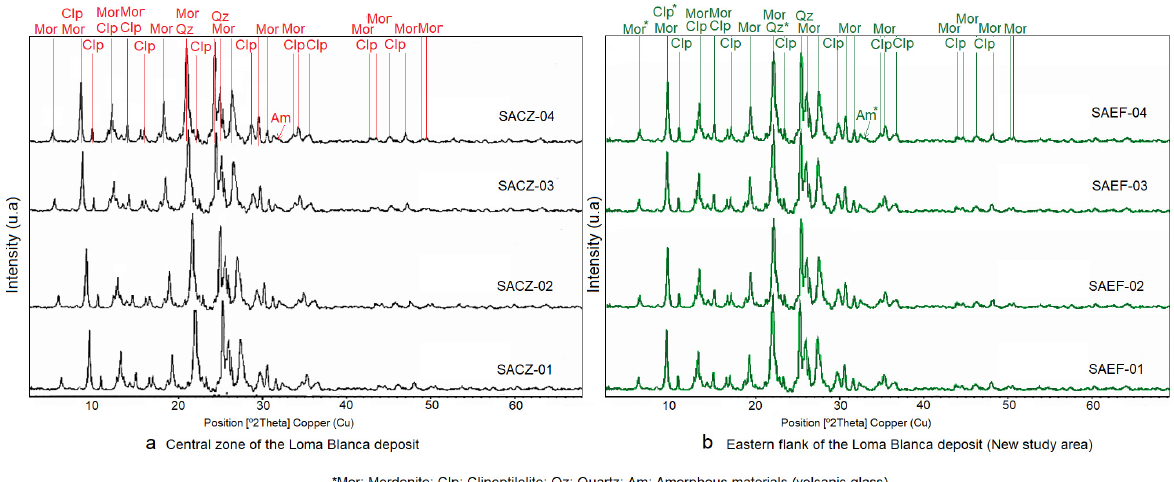
Figure 2. X-ray diffraction patterns obtained from the analysis of the samples investigated: ( a ) corresponds to those from the Loma Blanca deposit; ( b ) represents the samples from the study area.